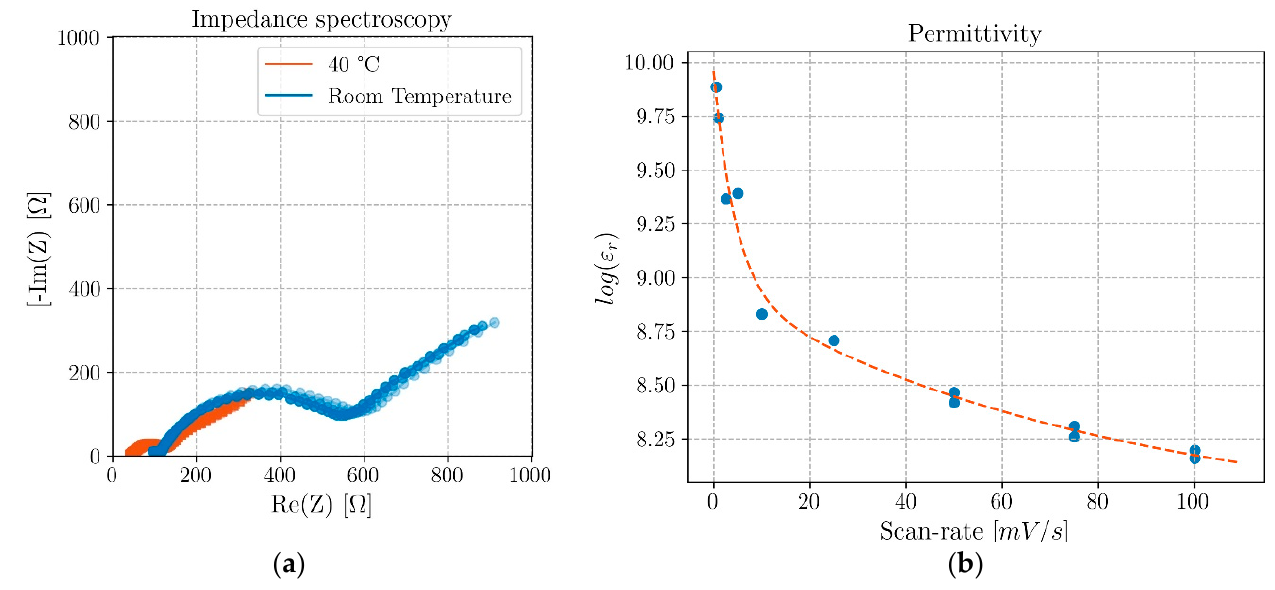
Figure 5. Electrochemical cell analyses; ( a ) Impedance spectroscopy at different temperatures obtained by EIS; ( b ) Permittivity at 40 °C obtained by cyclic voltammetry, CV cycles, for differ-ent scanning rates and fitted by a two-phase exponential decay curve.